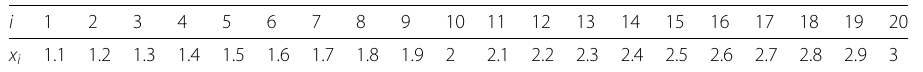
Table 7 Domain discretization for